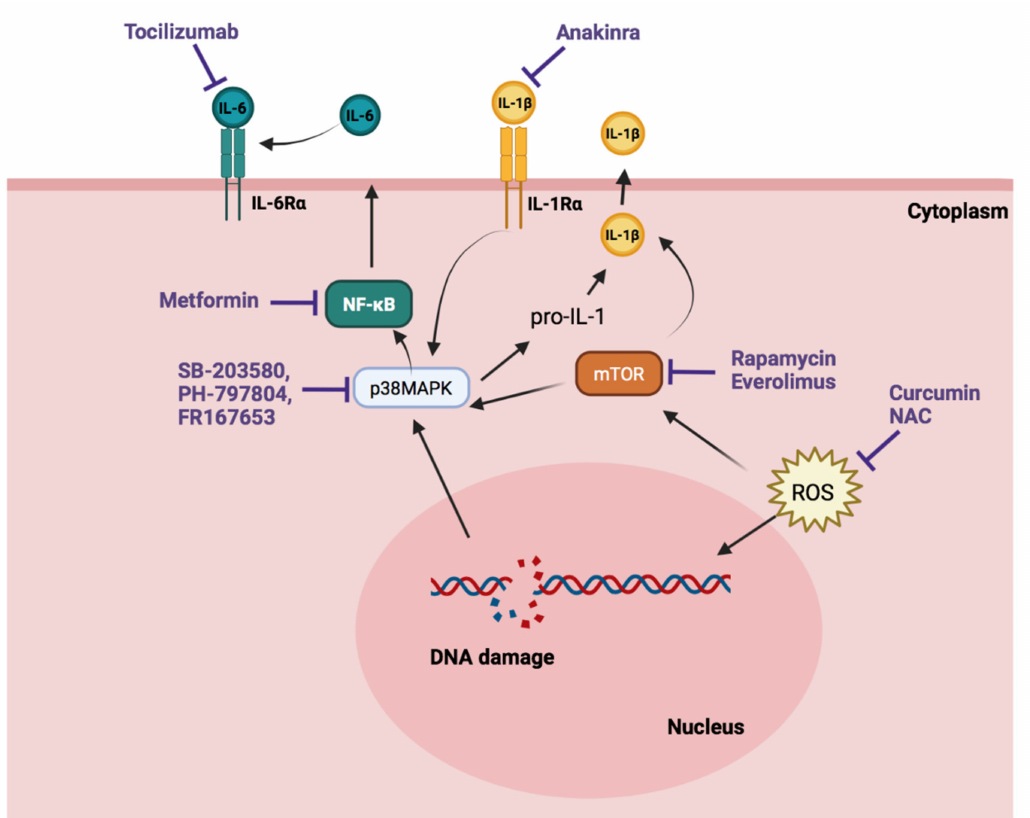
Figure 4. Pathways and inhibitors of cellular senescence. MAPK: mitogen-activated protein kinase; mTOR: mammalian target of rapamycin; NAC: N-acetyl cysteine; NF- κ B: nuclear factor-kappa B; ROS: reactive oxygen